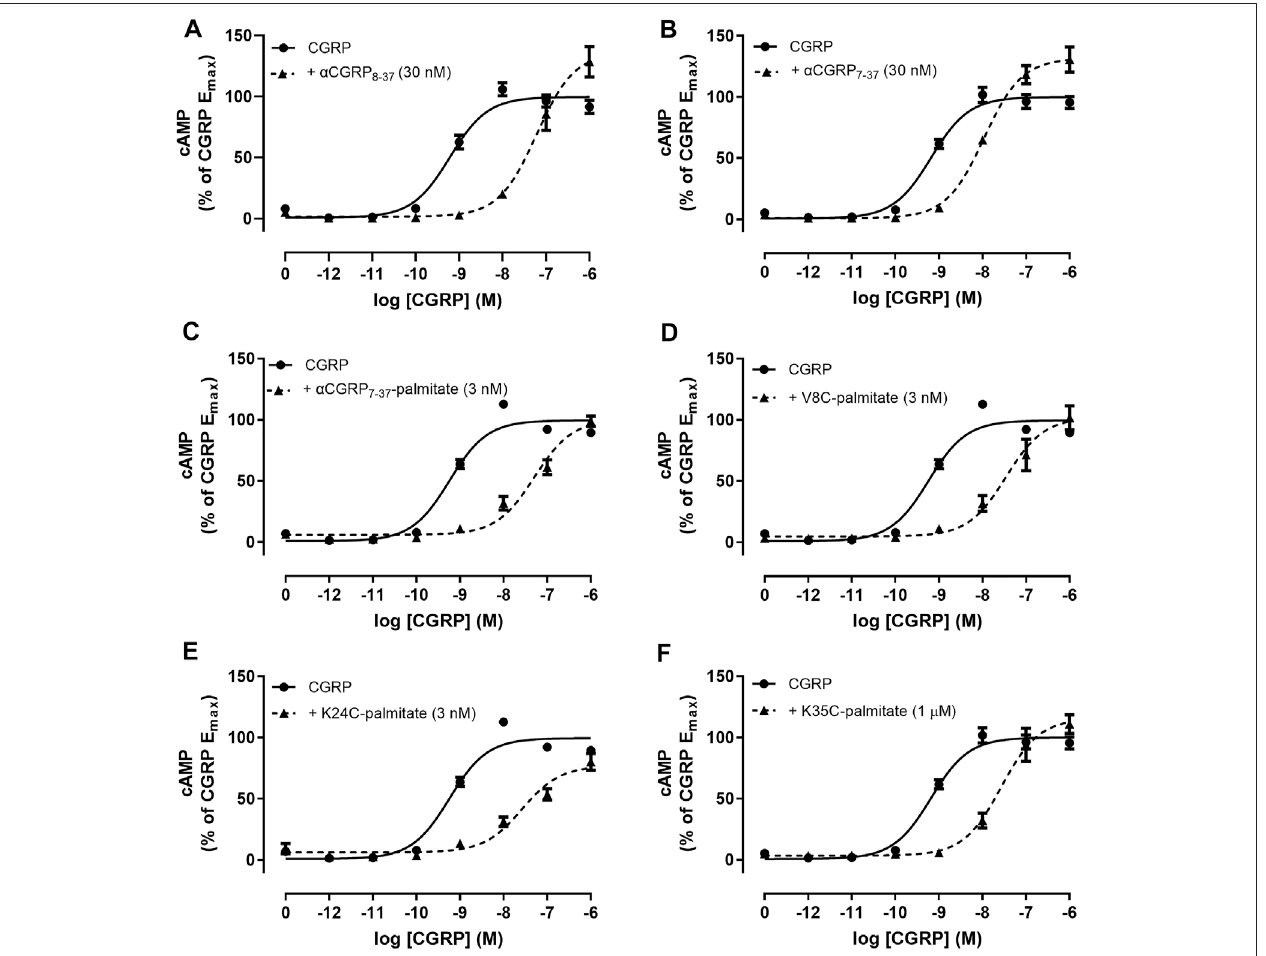
FIGURE 4 | Antagonism by α CGRP 8-37 , α CGRP 7-37 , and lipidated analogues in SK-N-MC cells. CGRP concentration-response curves were generated in the absence or presence of (A) α CGRP 8-37 , (B) α CGRP 7-37 , (C) α CGRP 7-37 -palmitate, (D) V8C-palmitate, (E) K24C-palmitate, or (F) K35C-palmitate. Data points are plotted as a percentage of maximal CGRP-stimulated cAMP production with mean ± SEM of fi ve to six independent experiments.